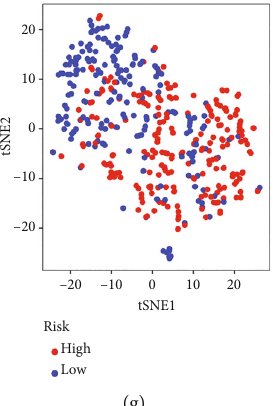
Figure 1: Establishment of the risk signature. (a, b) LASSO regression analysis was used to screen the prognostic optimal candidate genes. (c) Multi-Cox analysis was conducted for the construction of the risk signature. (c – g) PCA and t-SNE analyses were used to visualize the dimensionality reduction annotated by the risk